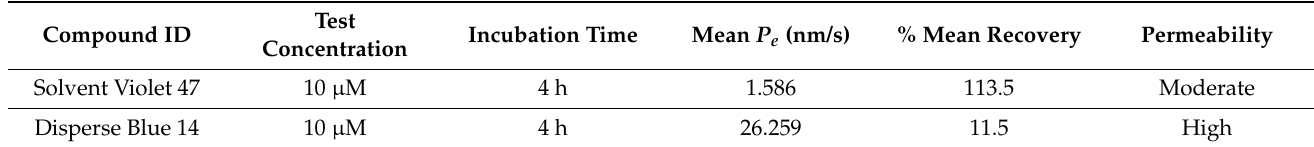
Table 4. Blood–brain barrier permeability assay results. Moderate permeability: 1 < P e < 10 nm/s. High permeability: P e > 10 nm/s. Compound